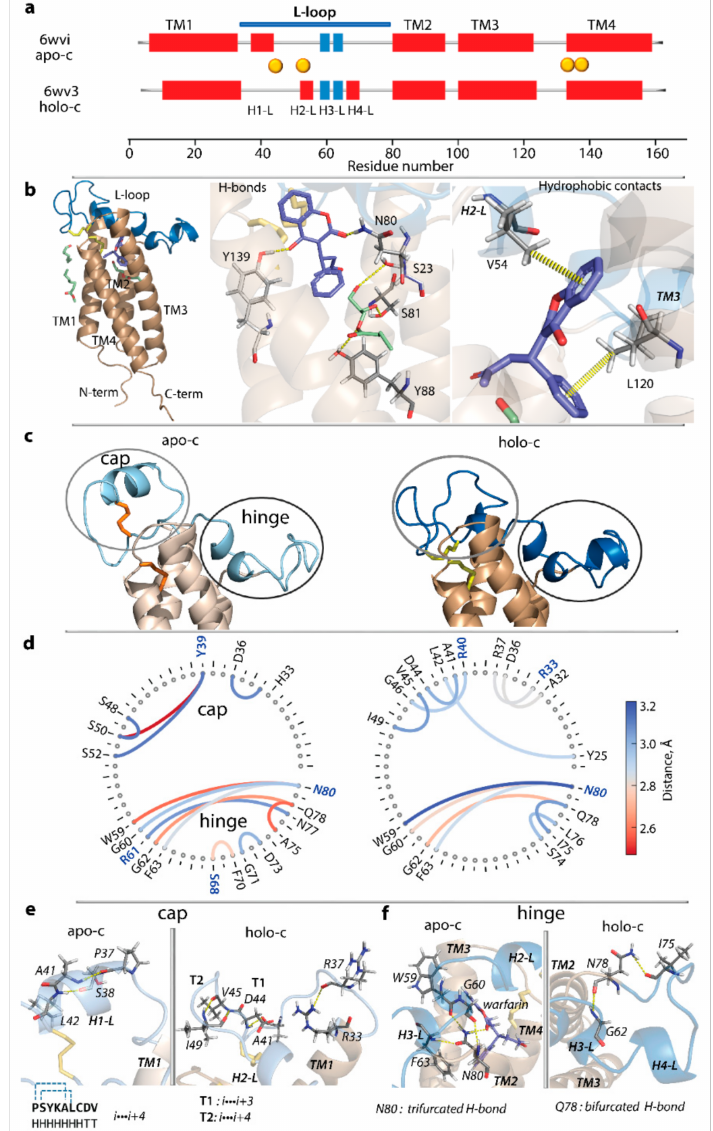
Figure 2. Structure of two crystallographic forms of the oxidised state of VKOR. ( a ) Secondary structures interpretation (DSSP) of crystallographic structures of VKOR-like protein from Takifugu rubripes (free ligand, 6wvi) and human VKOR (co-crystallised with warfarin and glycerol monooleate, 6wv3). α - and 3 10 -helices are shown in red and blue, respectively, and numbered as in [15]. L-loop segment is delimited by a blue bar; positions of cysteine residues are indicated by orange balls. ( b ) Structure of human VKORC1 co-crystallised with warfarin and glycerol monooleate (6wv3) (left). H-bonds (middle) and hydrophobic interactions (right) stabilising warfarin and glycerol monooleate in structure 6wv3. ( c ) L-loop conformation from crystallographic structures 6wvi (apo-c) and 6wv3 (holo-c). ( d ) H-bonds stabilising the cap and hinge in L-loop in two crystallographic forms showed as a string diagram. Residues contributing to H-bonding by their side chains are labelled in blue bold. ( e , f ) H-bonds stabilising α -helix and turns in L-loop cap in two crystallographic forms ( e ) and bifurcated and trifurcated H-bonds of residues N80 and Q78 ( f ) in both crystallographic structures, illustrated for holo-c form. ( b , c , e ) Protein is shown as cartoon with L-loop in blue (6wvi) and light blue (6wv3), TMD domain in brown (6wvi) and light brown (6wv3), and disulfide bridges as yellow (6wvi) and orange (6wv3) sticks; non-covalent interactions (H-bonds and hydrophobic contacts) are shown by yellow dashed lines. Figures were prepared from atomic coordinates. Numbering of residues corresponds to the respective sequences of crystallographic